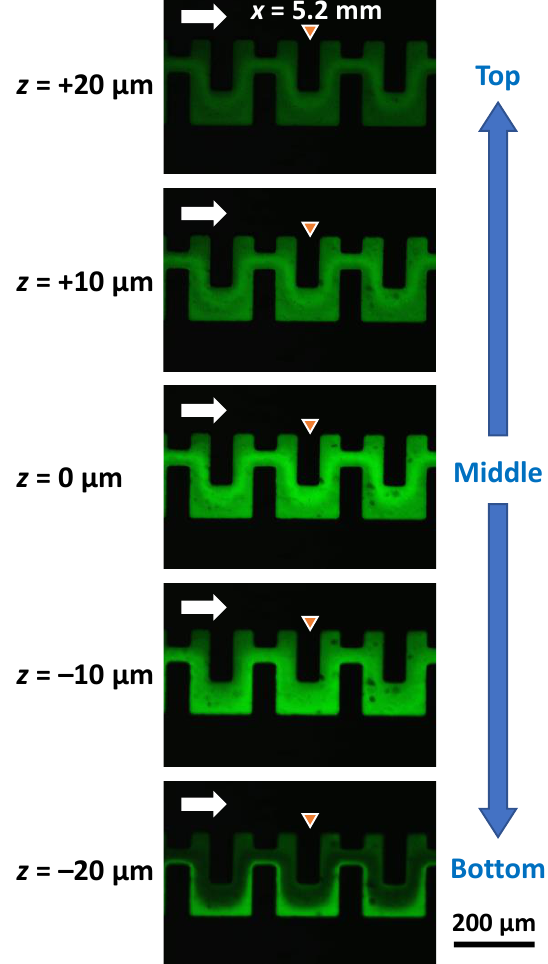
Figure 13. Confocal microscopy images of the mixing behavior at different focal xy -planes with a distance of 10 µm in the height direction ( z -axis direction), in which z = 0 is the middle plane of the microchannel height, and z = –20 µm and z = 20 µm are the top and bottom surfaces of the microchannel, respectively. Pure water and fluorescein-dyed water (0.1 mol/m 3 ) were introduced into the asymmetric micromixers (M5) at each flow rate of 5 µL/min, equivalent to a total flow rate of 10 µL/min and Re = 1.3 in the microchannel.